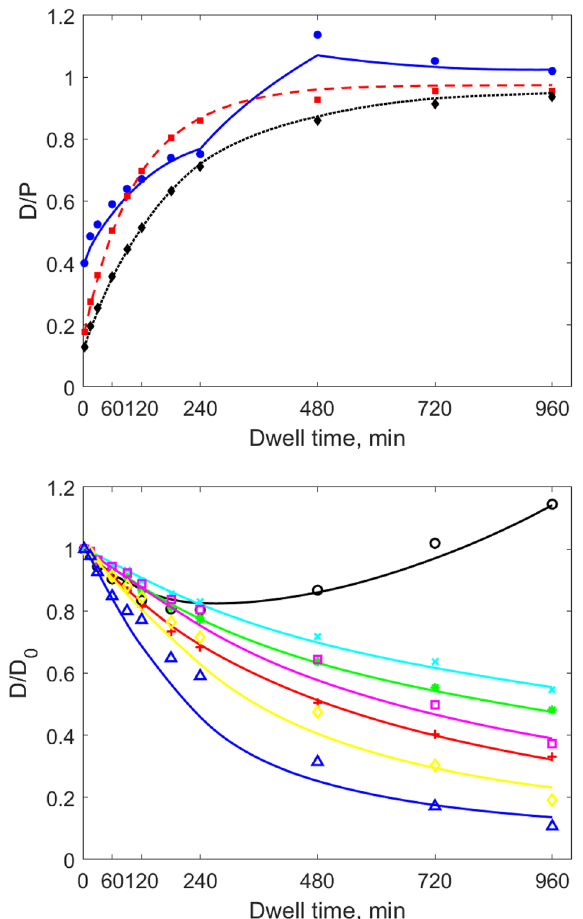
Figure 5. Mean measured and simulated (using the extended model) values from all patients of (upper panel) dialysate to plasma concentration ratio, D/P, for small solutes: glucose (blue circles and solid line), urea (red squares and dashed line), and creatinine (black diamonds and dotted line) and (bottom panel) normalized (by initial value) dialysate concentration, D/D 0 , for LMW icodextrin oligomers (Fraction 1 – circles) and HMW polymers (Fraction 2 – plus marker, Fraction 3 – filled circles, Fraction4 – crosses, Fraction 5 – squares, Fraction 6 – diamonds, Fraction 7–triangles), during 16-h peritoneal dialysis with 7.5% icodextrin. Data are denoted by symbols, whereas lines correspond to the mean numerical